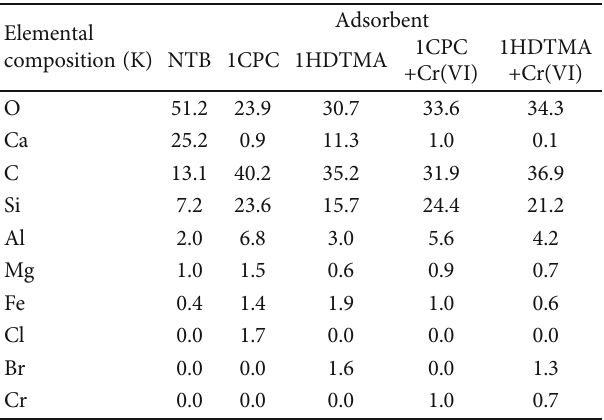
Table 8: Elemental composition (%) of NTB, 1CPC, 1HDTMA, and MTBs after Cr(VI)